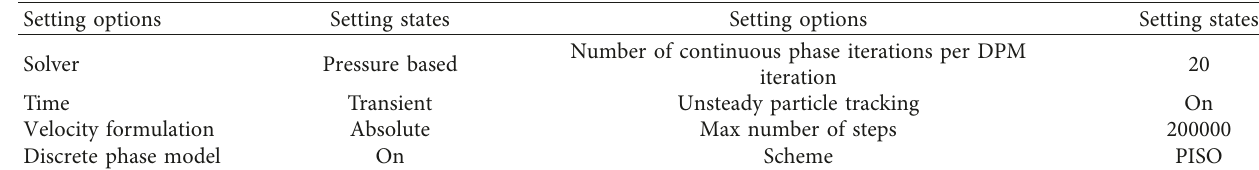
Table 2: Parameter settling of the discrete phase model.